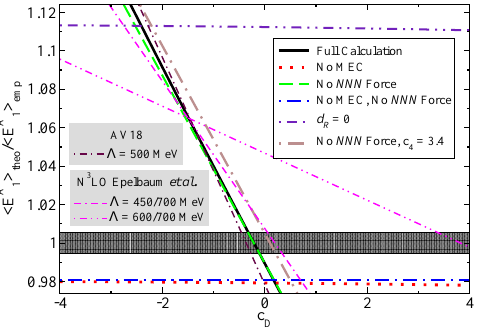
D D E E Fig. 4. The ratio E A E A / using the N 3 LO NN poten- 1 1 th emp tial [44] with and without the local N 2 LO NNN interaction [42], and the axial current with and without MEC ( c D , c E are var- ied along the averaged trajectory of Fig. 3). The shaded area is twice the experimental uncertainty. Also shown: results for the phenomenological AV18 potential (with Λ = 500 MeV imposed in the current), and for the N 3 LO NN potential of Epelbaum et al. [46] (with Λ = 450 , 600 MeV, and a 700 MeV spectral- function cuto ff in the two-pion exchange). Figure taken from